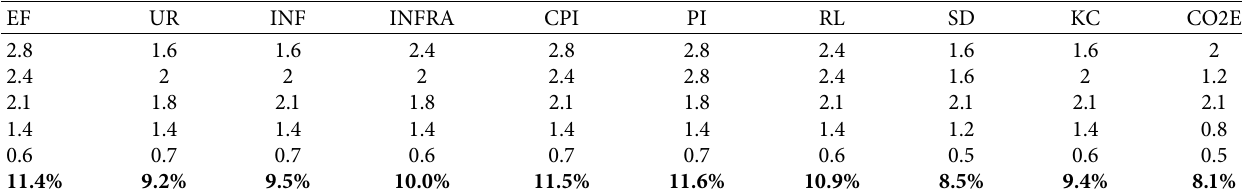
Table 3: Transformed survey responses after factoring in expert alpha values.